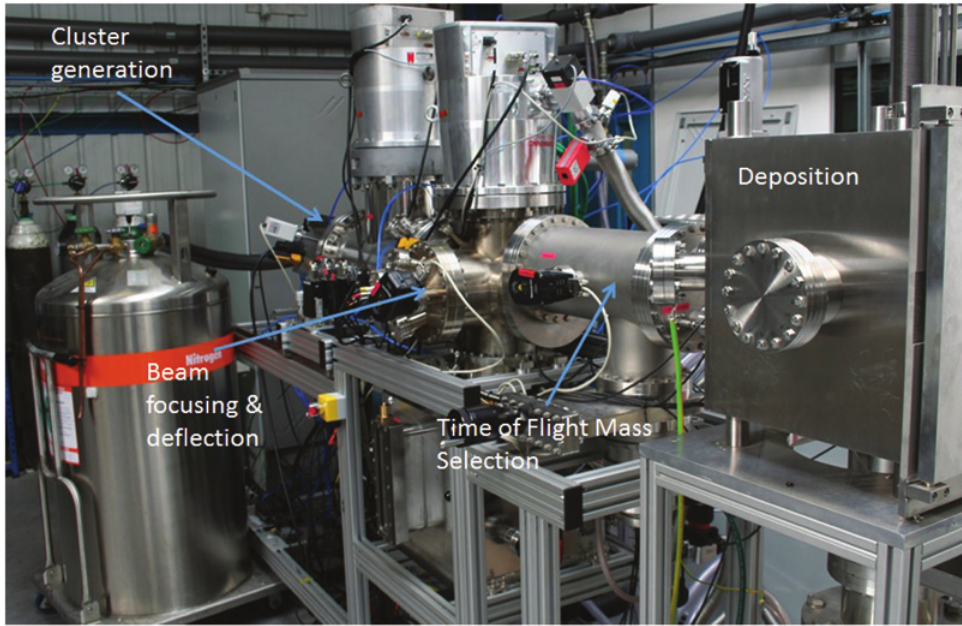
Figure 2: Nanocluster deposition system under development. © Teer Coatings